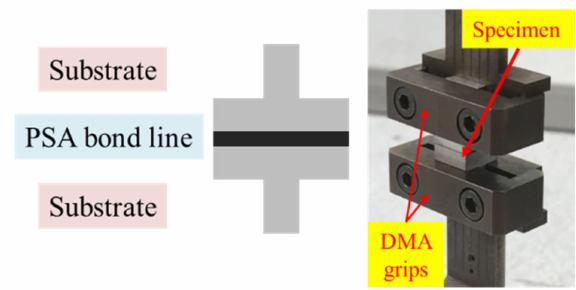
Figure 2. Uniaxial test sample and fixture of the